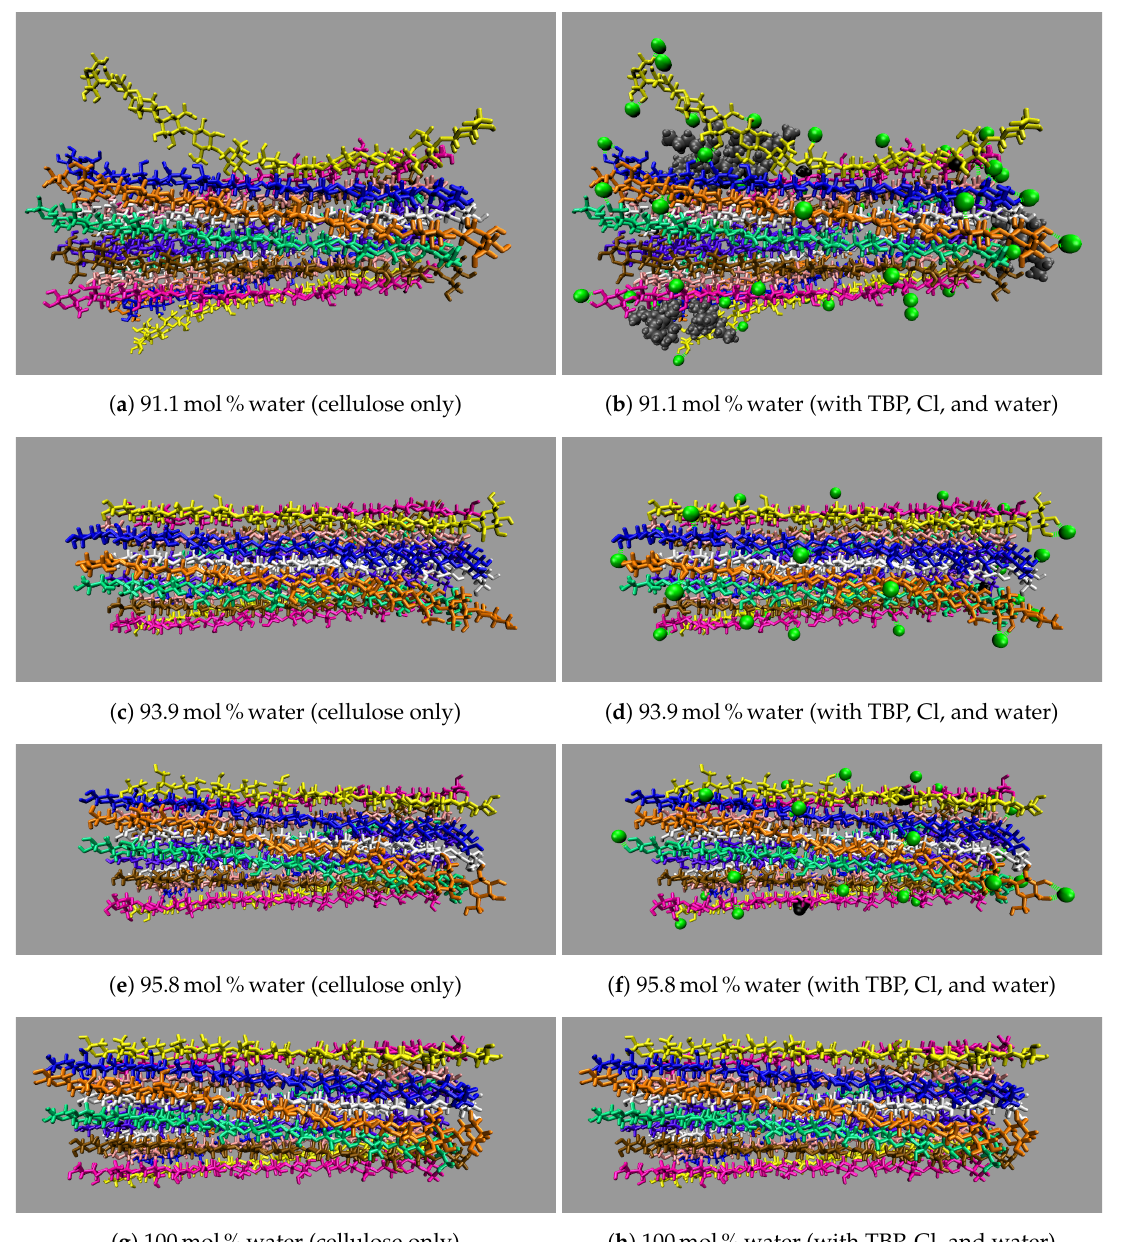
Figure A10. Side view images of the cellulose bundle dissolution at 600ns, showing all the nearby TBP, Cl, and water molecules (Part 2 of 2) at: ( a ) 91.1mol%water (cellulose only); ( b ) 91.1mol%water (with TBP, Cl, and water); ( c ) 93.9mol%water (cellulose only); ( d ) 93.9mol%water (with TBP, Cl, and water); ( e ) 95.8mol%water (cellulose only); ( f ) 95.8mol%water (with TBP, Cl, and water); ( g ) 100mol%water (cellulose only); and ( h ) 100mol%water (with TBP, Cl, and